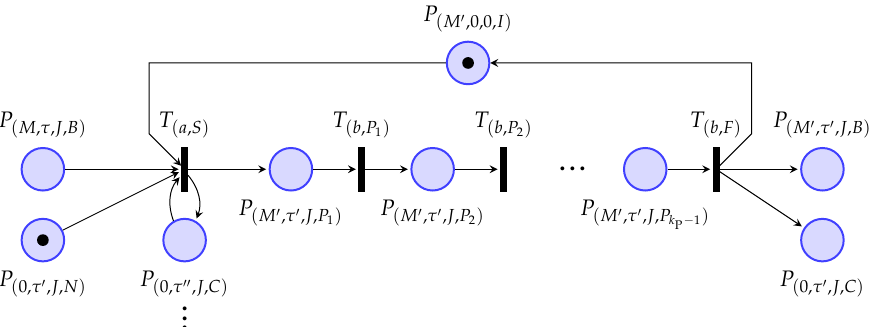
Figure 3. Illustration of the production sequences for the execution of task τ (cid:48) of job J on machine M (cid:48) as it is generated in the Algorithms 1 and 2, with a = ( M , M (cid:48) , τ , τ (cid:48) , J ) and b = ( M (cid:48) , M (cid:48) , τ (cid:48) , τ (cid:48) , J ) . The tokens in the sequence are depicted as they are initialized in Algorithm 1. As at initialization no task τ or τ (cid:48)(cid:48) is already completed, the places P ( M , τ , J , B ) and P ( 0, τ (cid:48)(cid:48) , J , C ) are not marked and the transition T ( M , M (cid:48) , τ , τ (cid:48) , J , S ) is not